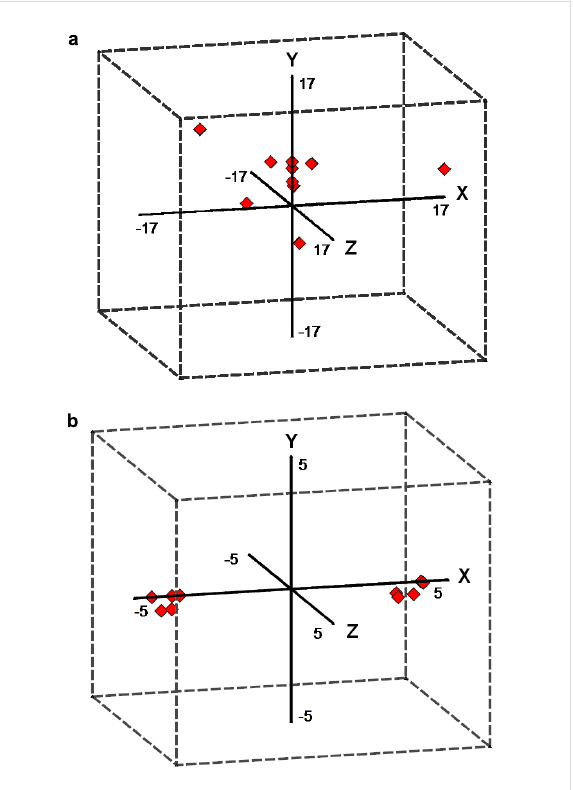
Figure 3: Directions of solvated (a) dipole moments and (b) transition moments from origin (0,0,0).